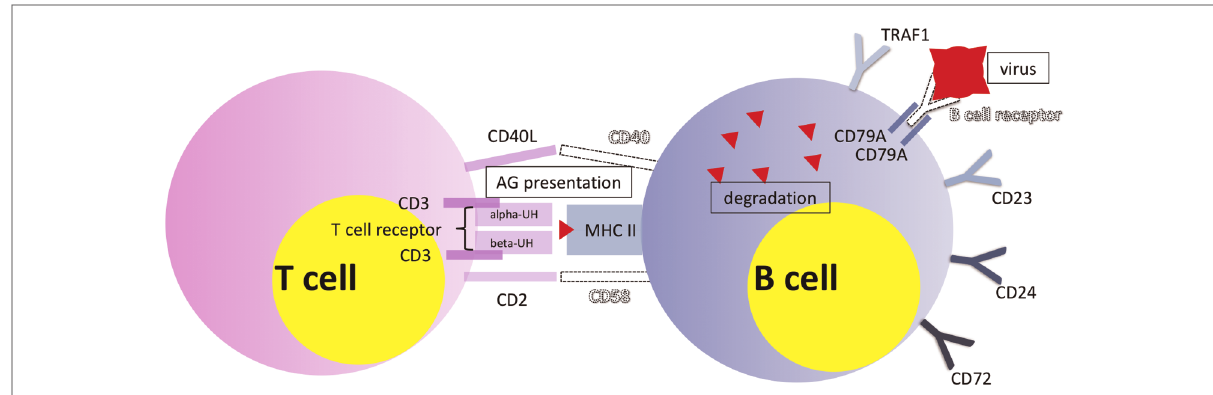
FIGURE 4 Visualization of signi fi cantly overexpressed genes associated with B and T cells, demonstrating particularly their interaction (40). Objects shown dashed and virus symbol: added for demonstration